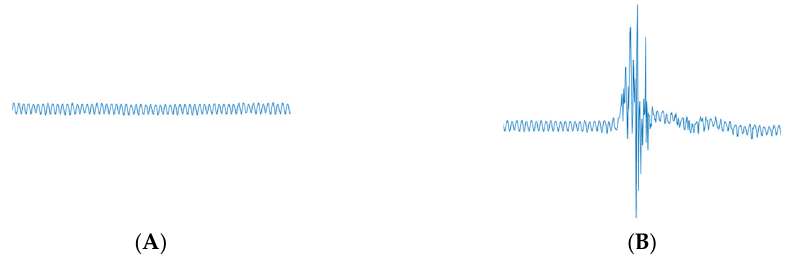
Figure 6. EMG comparison with and without movement. ( A ) No action. ( B ) Action.